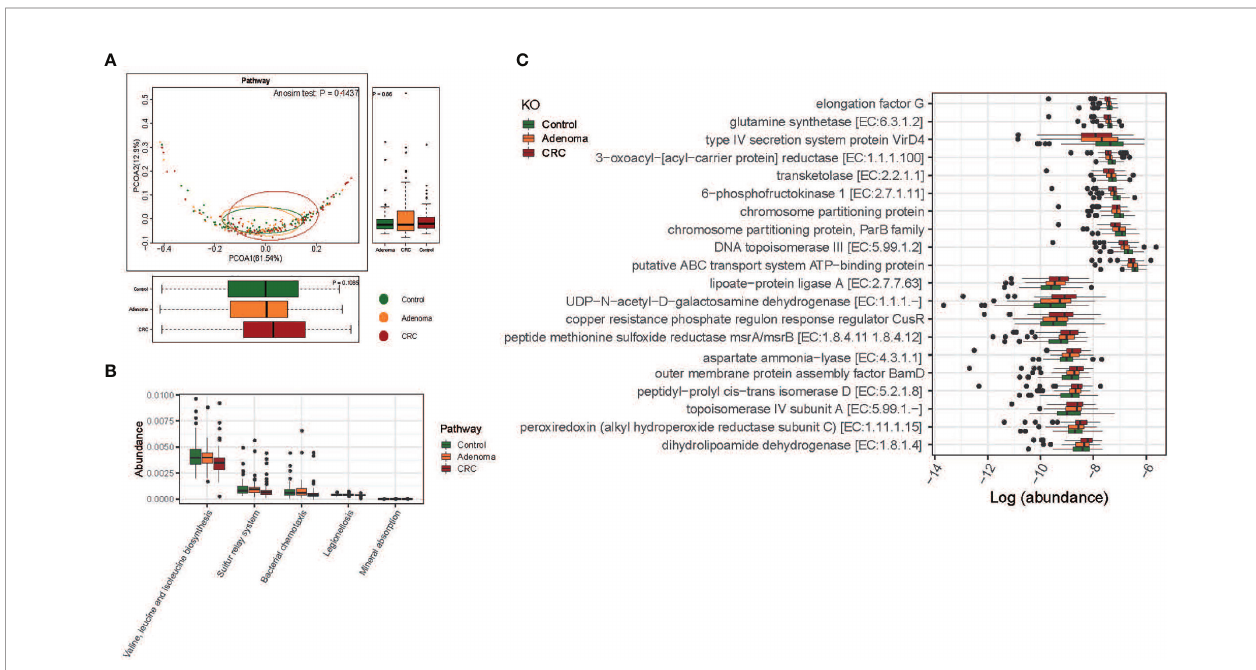
FIGURE 4 | Functional differences of gut microbiome among the control (colored in green), adenoma (colored in amber), and CRC (colored in dubonnet) groups. (A) Principal coordinate analysis of the KEGG pathways. (B) The pathways that were different in relative abundance between the control and CRC groups. (C) The top 10 KOs that showed increased (top 10) or decreased (lower 10) relative abundance in the CRC group compared with that in the control